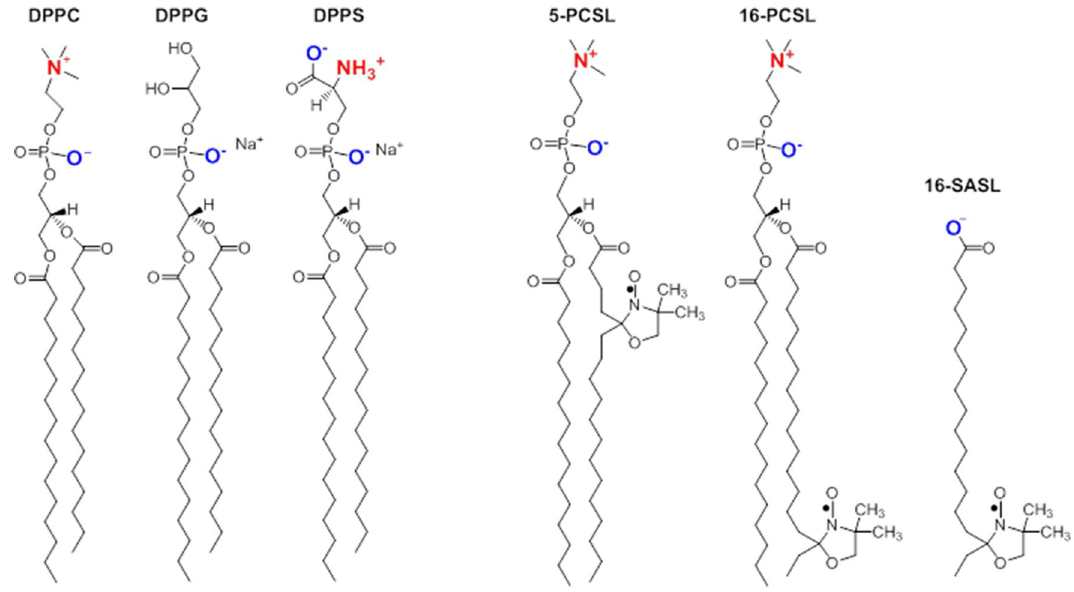
Figure 1. Chemical structures of the lipids and spin labels used. In red and blue, positive and negative groups,